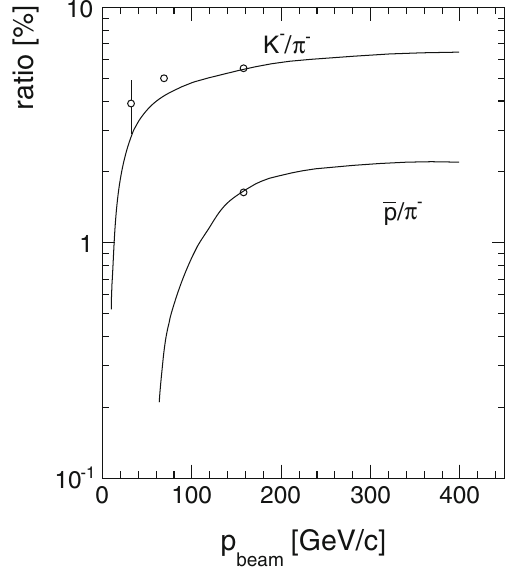
√ Fig. 5 K − / π − and p/ π − ratios as a function of s . The full lines cor- respond to the new determination of the energy dependences of K − [49] and p [50] cross sections by the NA49 collaboration.The measure- ment of the K − / π − ratio at 32 GeV/c and the k − / π − and p/ π − ratios at 158 GeV/c beam momentum as well as the correction deduced from the measured K 0 yields at 69 GeV/c are given as data points S